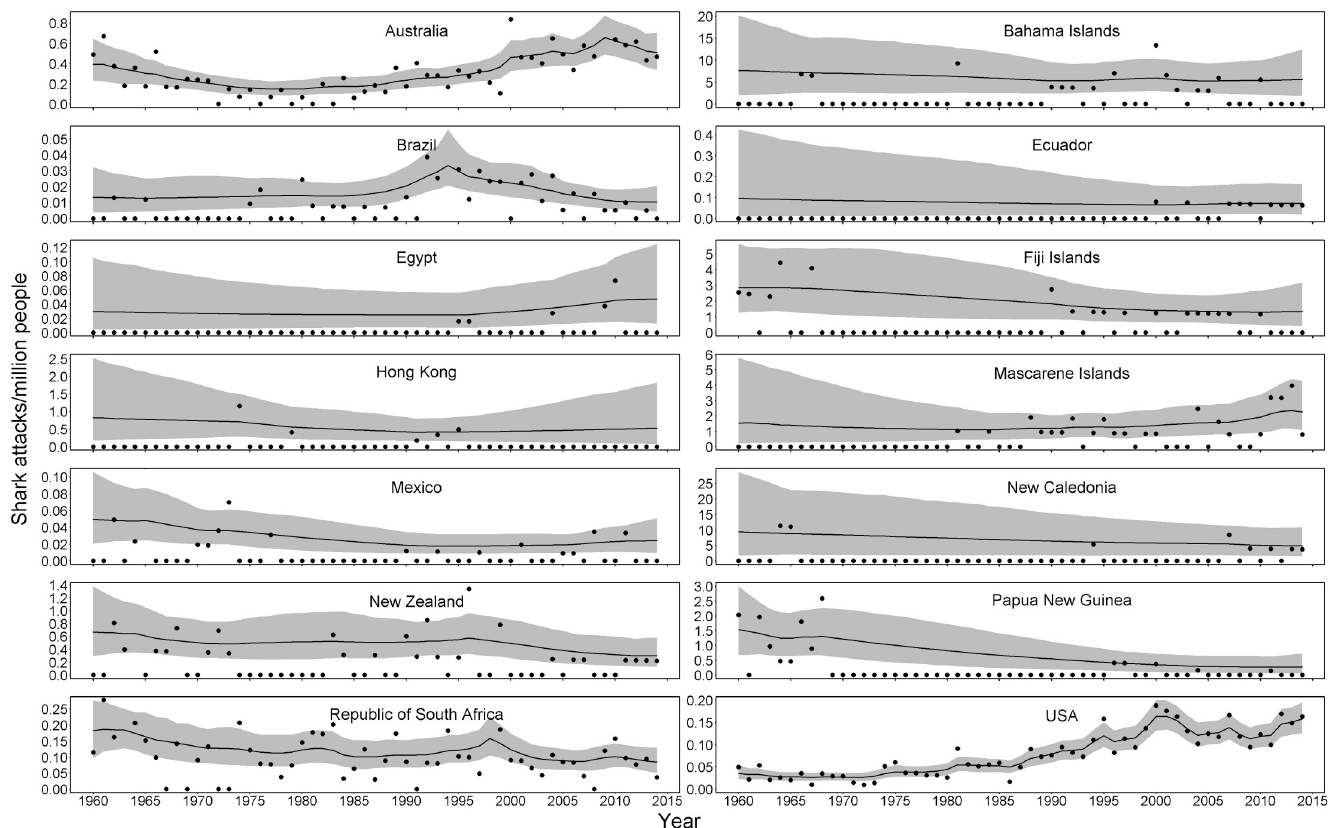
Fig 2. Shark attack rate (attacks per million people) from 1960–2015 for the 14 countries with the most shark attacks during this time. Black dots indicate annual rates, the black line represents the temporal trend, and the gray region indicates uncertainty (95% credible region) around the trend.